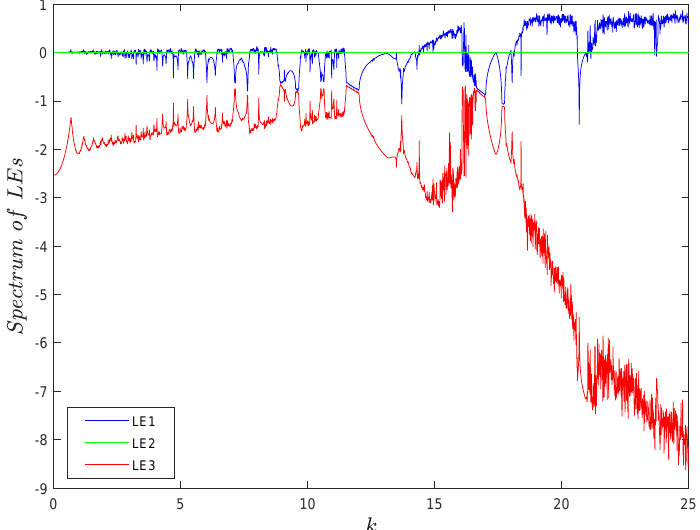
Figure 5. The Lyapunov exponent spectrum of VdPVP with respect to parameter k when ρ = 0.6, ω = 5.9. (The blue line represents the positive Lyapunov exponent, the green line represents the zero Lyapunov exponent, and the red line represents the negative Lyapunov